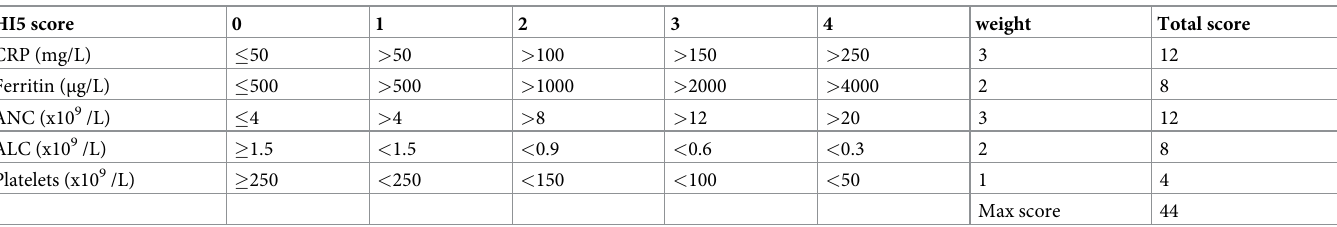
Table 1. The HI5 score algorithm.